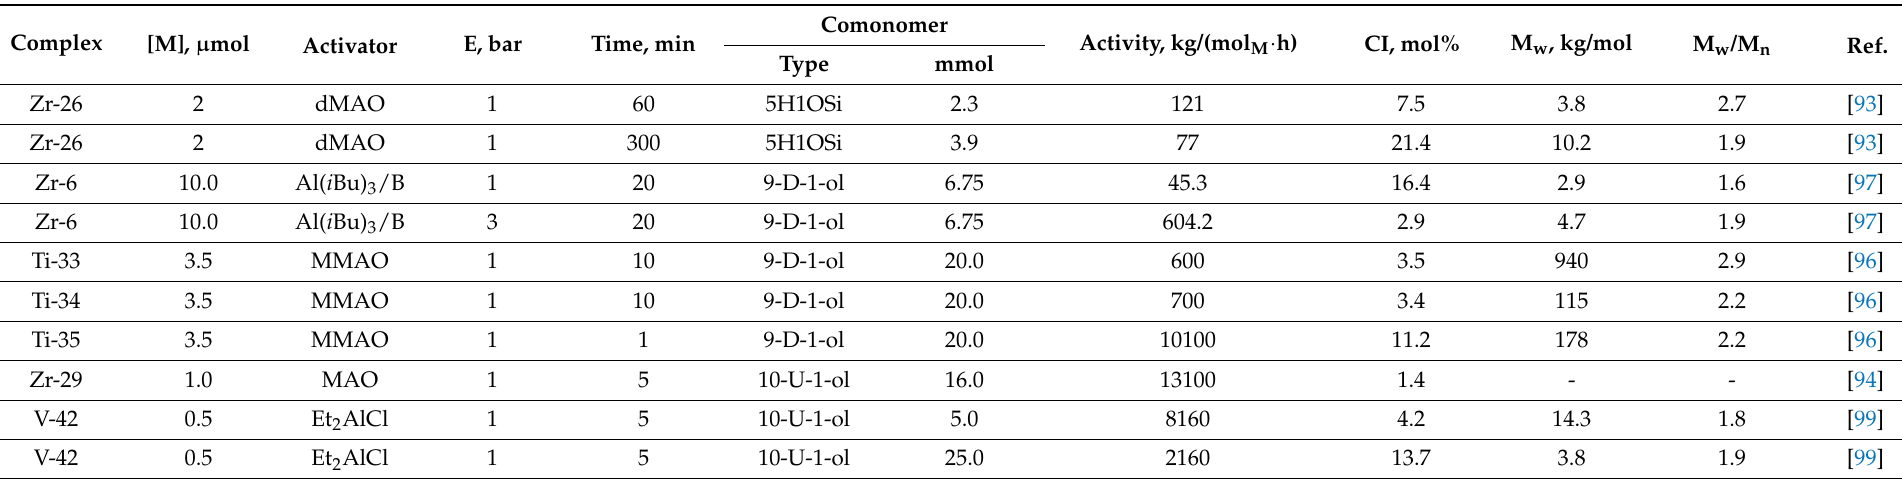
Table 7. Ethylene/ α , ω -alkenols copolymerization